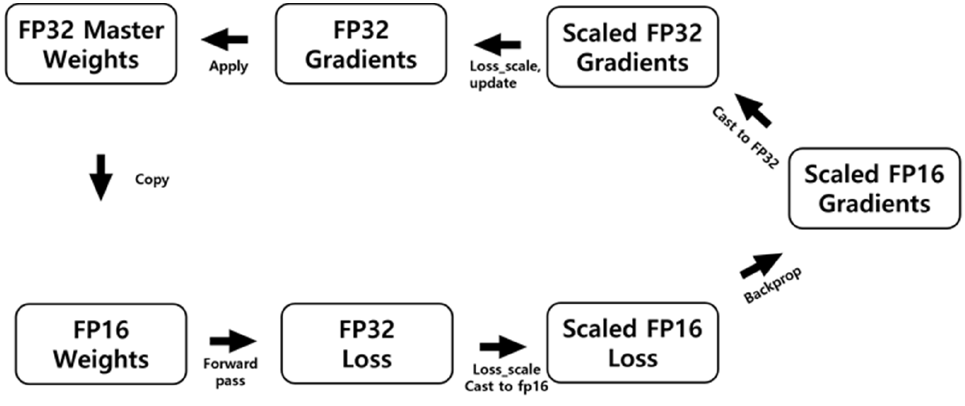
Figure 5. AMP training process.